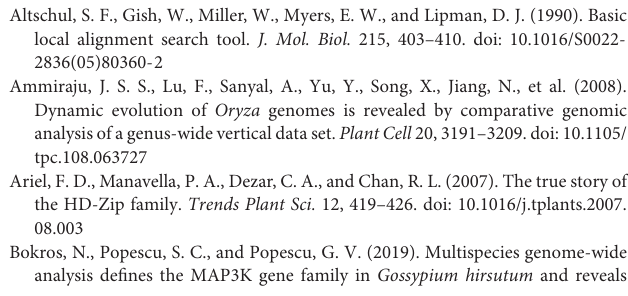
Supplementary Figure 2 | Collinear blocks for the 10 rice genomes (A) Oryza sativa var. japonica, (B) Oryza sativa var. indica, (C) Oryza glaberrima, (D) Oryza rufipogon, (E) Oryza nivara, (F) Oryza barthii, (G) Oryza glumaepatula, (H) Oryza meridionalis, (I) Oryza punctata, and (J) Oryza brachyantha. Supplementary Figure 3 | (A) Ka, (B) Ks, and (C) Ka/Ks values for START homologs of different Oryza species with respect to Oryza sativa var. japonica. Supplementary Figure 4 | Conditional gene expression pattern of START genes for (A) different developmental stages (B) various anatomical parts. Supplementary Table 1 | The locus ids of START genes along with sequence analysis information and phylogenetic code. Supplementary Table 2 | The detailed gene structure pattern of 10 Oryza genome, 5 (cid:48) -UTR, 3 (cid:48) -UTR, exon and Intron length. Supplementary Table 3 | Collinear genes number across 10 Oryza genome. Supplementary Table 4 | Ka, Ks, and Ka/Ks analysis among the gene pairs that follow different modes of duplication in Oryza sativa var. japonica